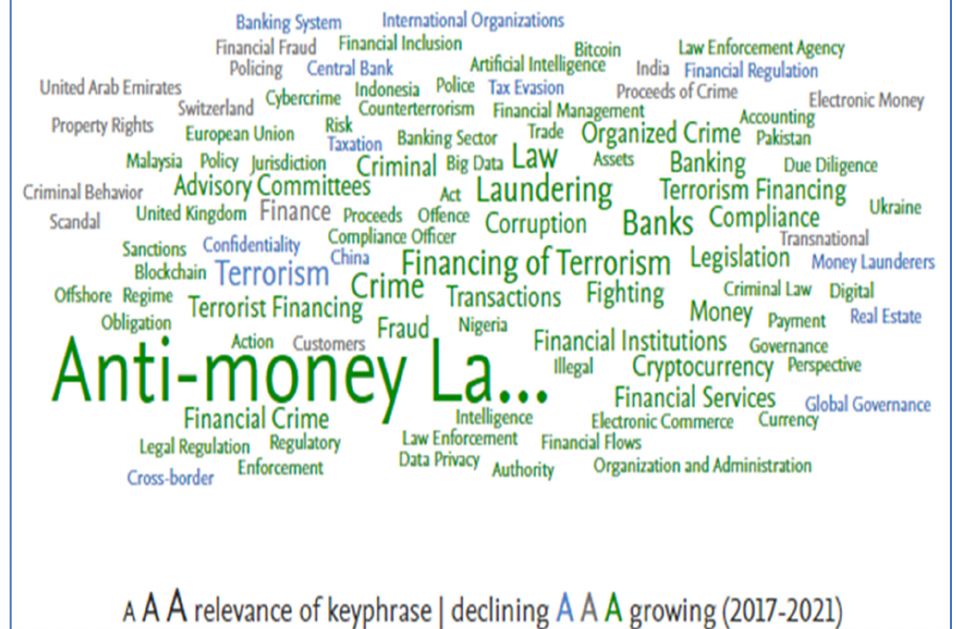
Figure 9. Map of keywords.